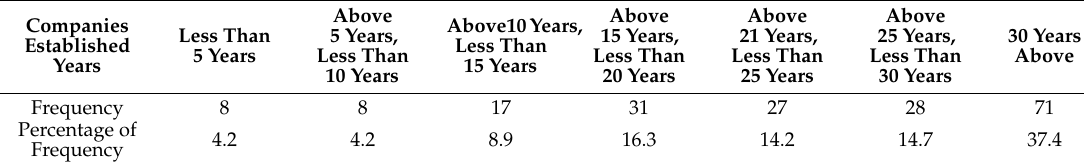
Table 2. Established years of companies.